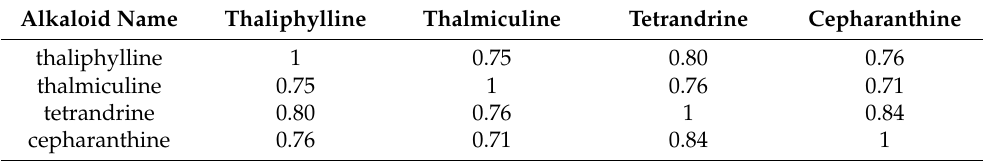
Table 6. Structural similarities among thaliphylline, thalmiculine, tetrandrine, and cepharanthine. Alkaloid